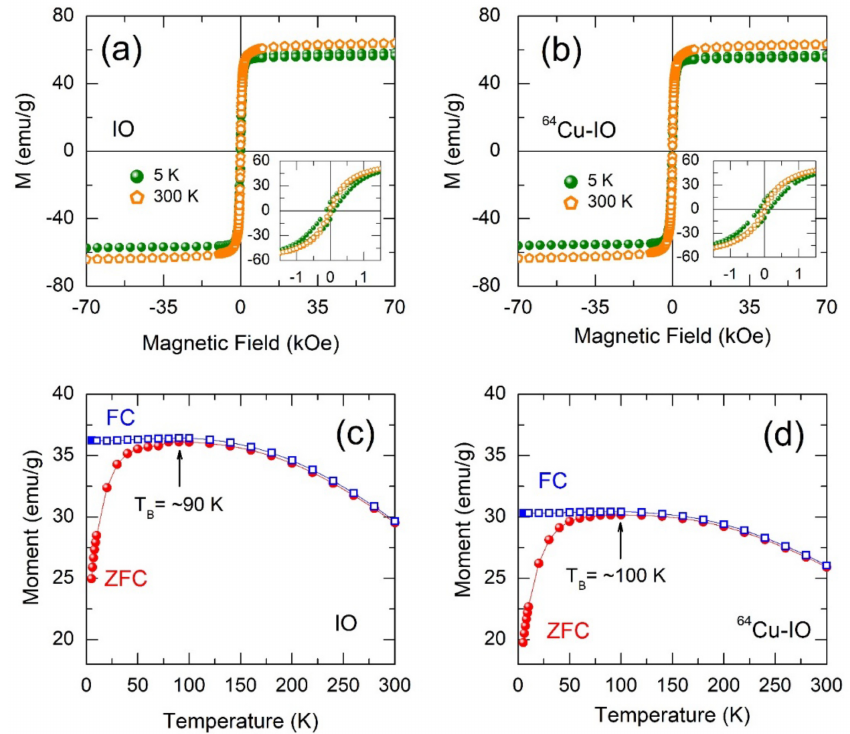
Figure 3. Mass magnetization of the ( a ) IO and ( b ) chelator-free 64 Cu-IO NPs obtained using a SQUID magnetometer. The insets of ( a , b ) show the magnified curves exhibiting a perfect superparamagnetic behavior at 300 K for both samples. The remanent magnetization and coercive field at 5 K were 10.3 emu/g and 100 Oe for ( c ) IO, and 10.8 emu/g and 200 Oe for ( d ) chelator-free 64 Cu-IO, respec- tively. Zero-field-cooled (ZFC) and field-cooled (FC) temperature-dependent magnetization curves (M-T) for IO and chelator-free 64 Cu-IO NPs under an applied magnetic field of 500 Oe. T B represents the blocking